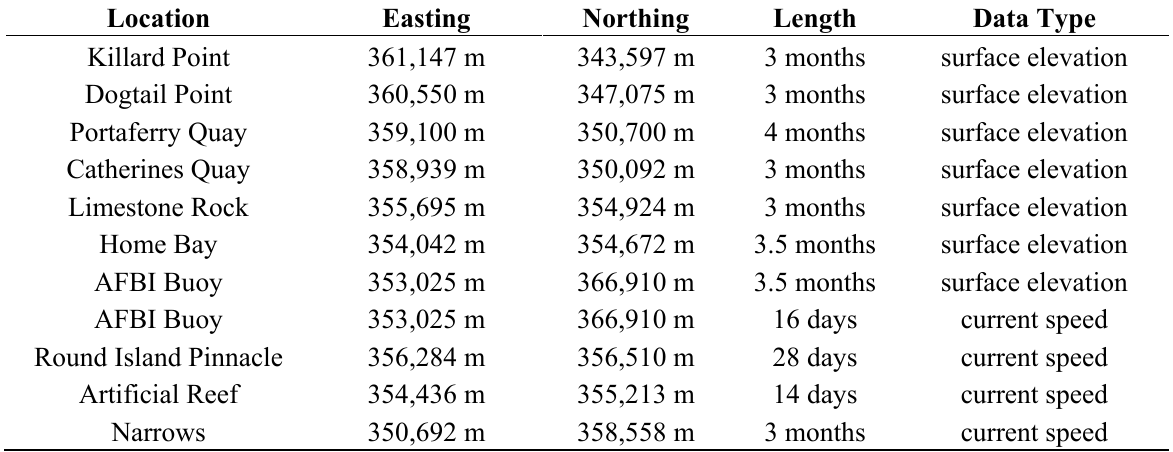
Table 1. Location (in Easting and Northing to Irish National Grid), type (surface elevation or current) and length of time (days or months) that data were collected for the calibration of the Strangford Lough hydrodynamic